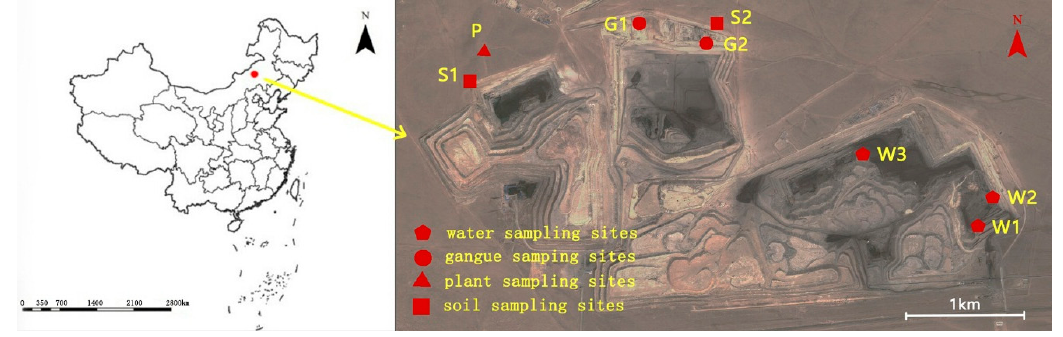
Figure 1. Study area and sample location in the open-cast germanium coal-mine area, Inner Mongolia, China.